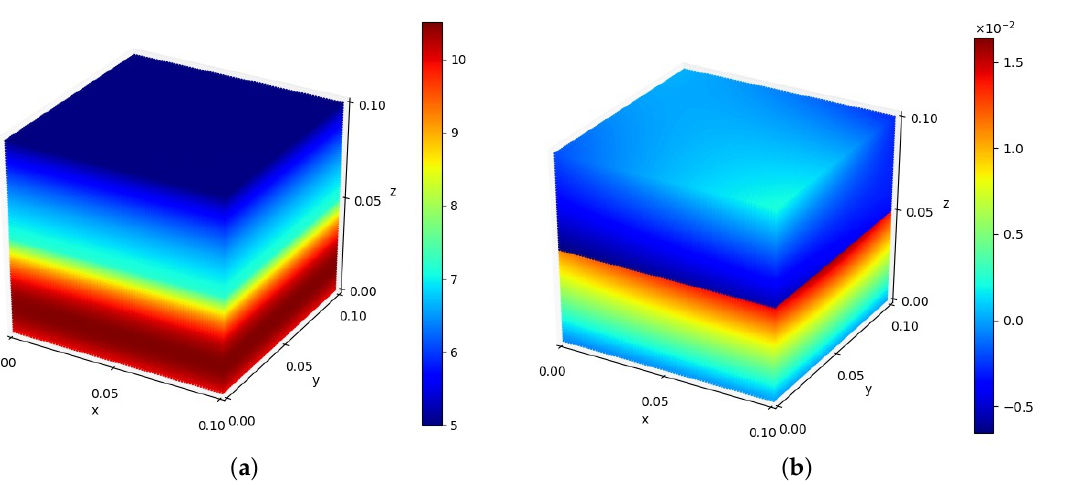
Figure 14. Physical model and interface geometry.